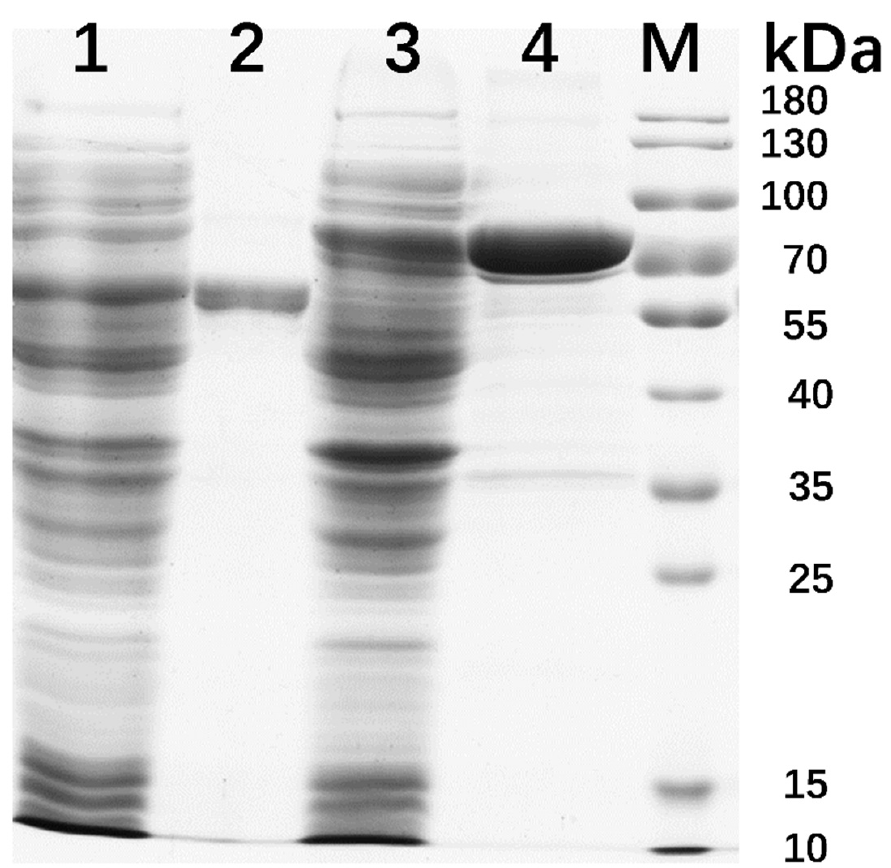
Figure 2. SDS-PAGE analysis of recombinant IDSPGA28-4 and IDSPGA28-16. Lane 1, crude ID- SPGA28-16; 2, puri fi ed IDSPGA28-16; 3, crude IDSPGA28-4; 4, puri fi ed IDSPGA28-4; M: standard protein marker.